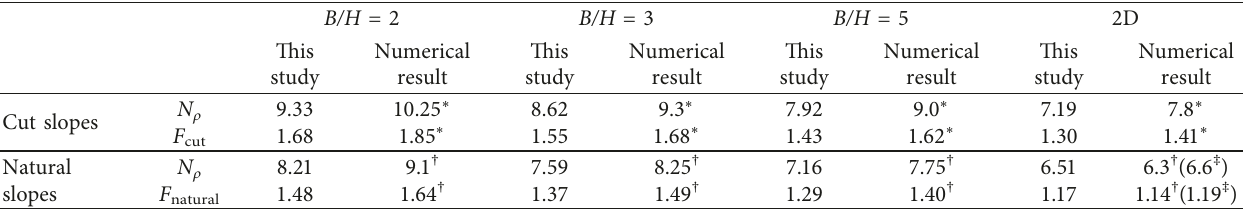
Table 1: Comparisons between calculated results from the analytical approach of this study and the numerical method of Li et al. (2009, 2010) for the example slope.